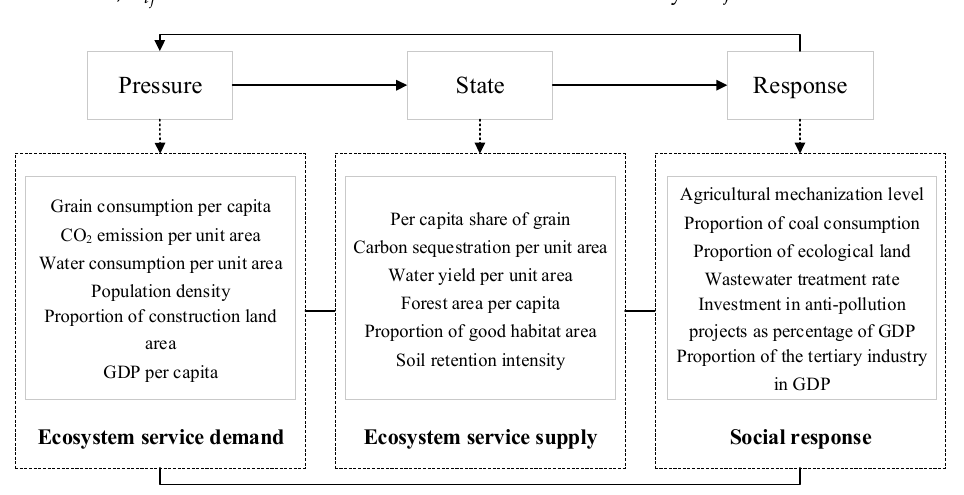
Figure 2. The evaluation framework of the ecological security embedded in the supply and demand of ecosystem services. Table 3. The evaluation index system and their weights of ecological security for the Pearl River